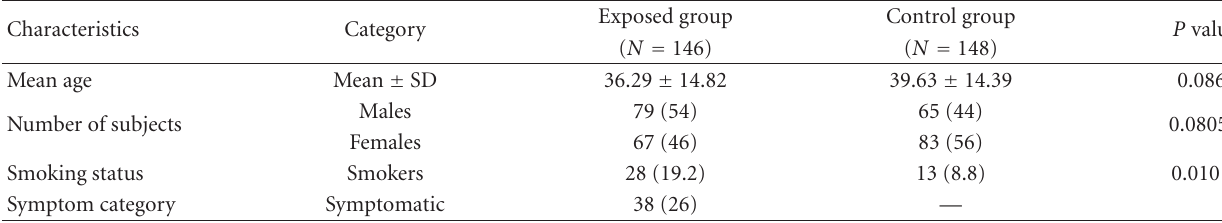
Table 1: Demographic characteristics of the study participants.